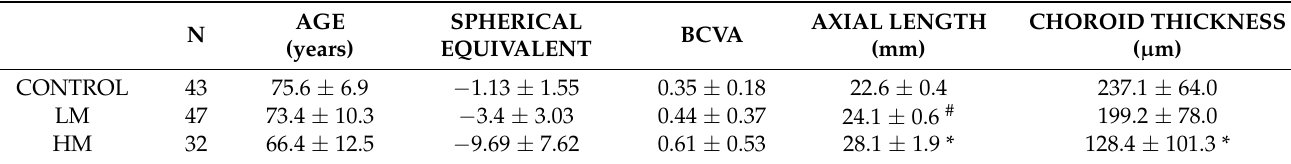
Figure 1. ( a ) The mean concentrations of complement Factor H. Values are expressed as mean ± SD. The difference in means (*) was established at a significance of p < 0.05; ( b ) the mean complement Factor D concentrations; ( c ) the correlation analysis between eyeball axial length and the measured complement Factor H concentrations; ( d ) inverse correlation between eyeball axial length and choroid thickness measured by OCT. Table 1. Clinical characteristics of the 122 studied patients. Patients’ ethnicity was Caucasian. Groups were distributed as HM, LM and control for emmetropia according to axial length. Each value represents the mean ± SD, * p < 0.05HM vs. Control group; # p < 0.05 LM vs. Control